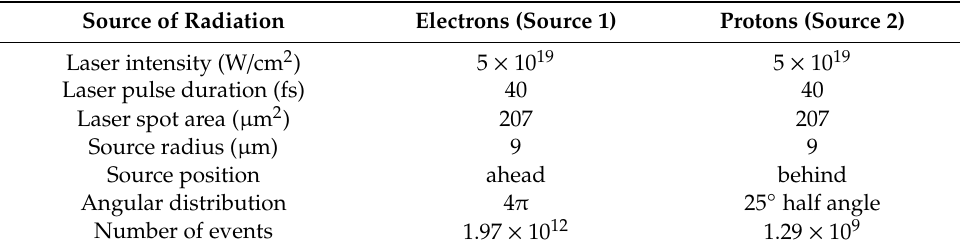
Table 1. Characteristics of source